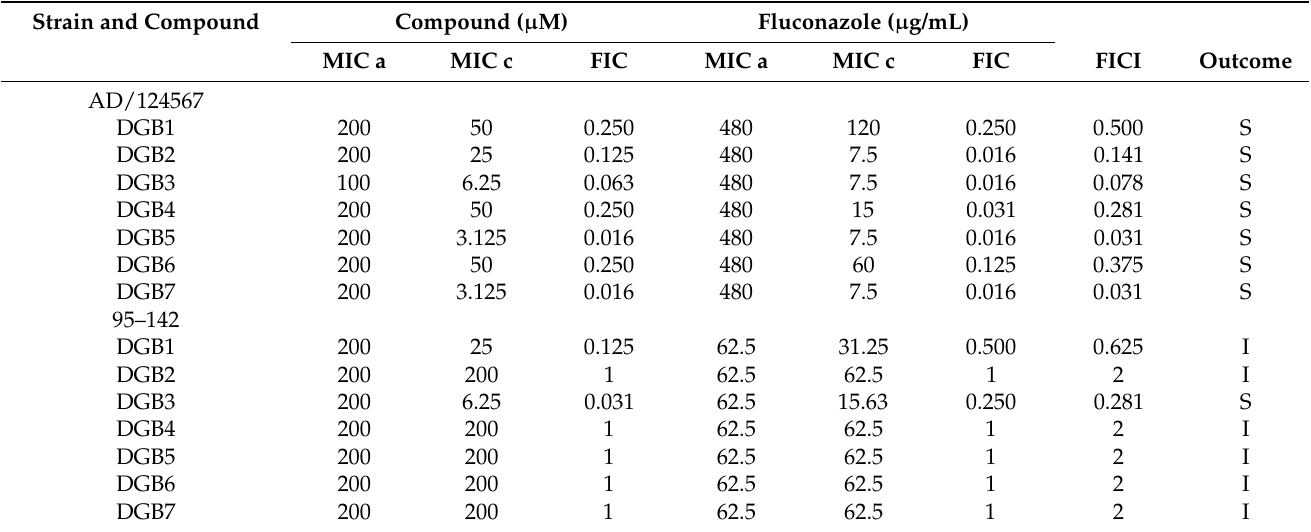
Table 1. Checkerboard assay of digoxin derivatives against strains AD/124567 and 95–142. Strain and Compound Compound ( µ M) Fluconazole ( µ g/mL)